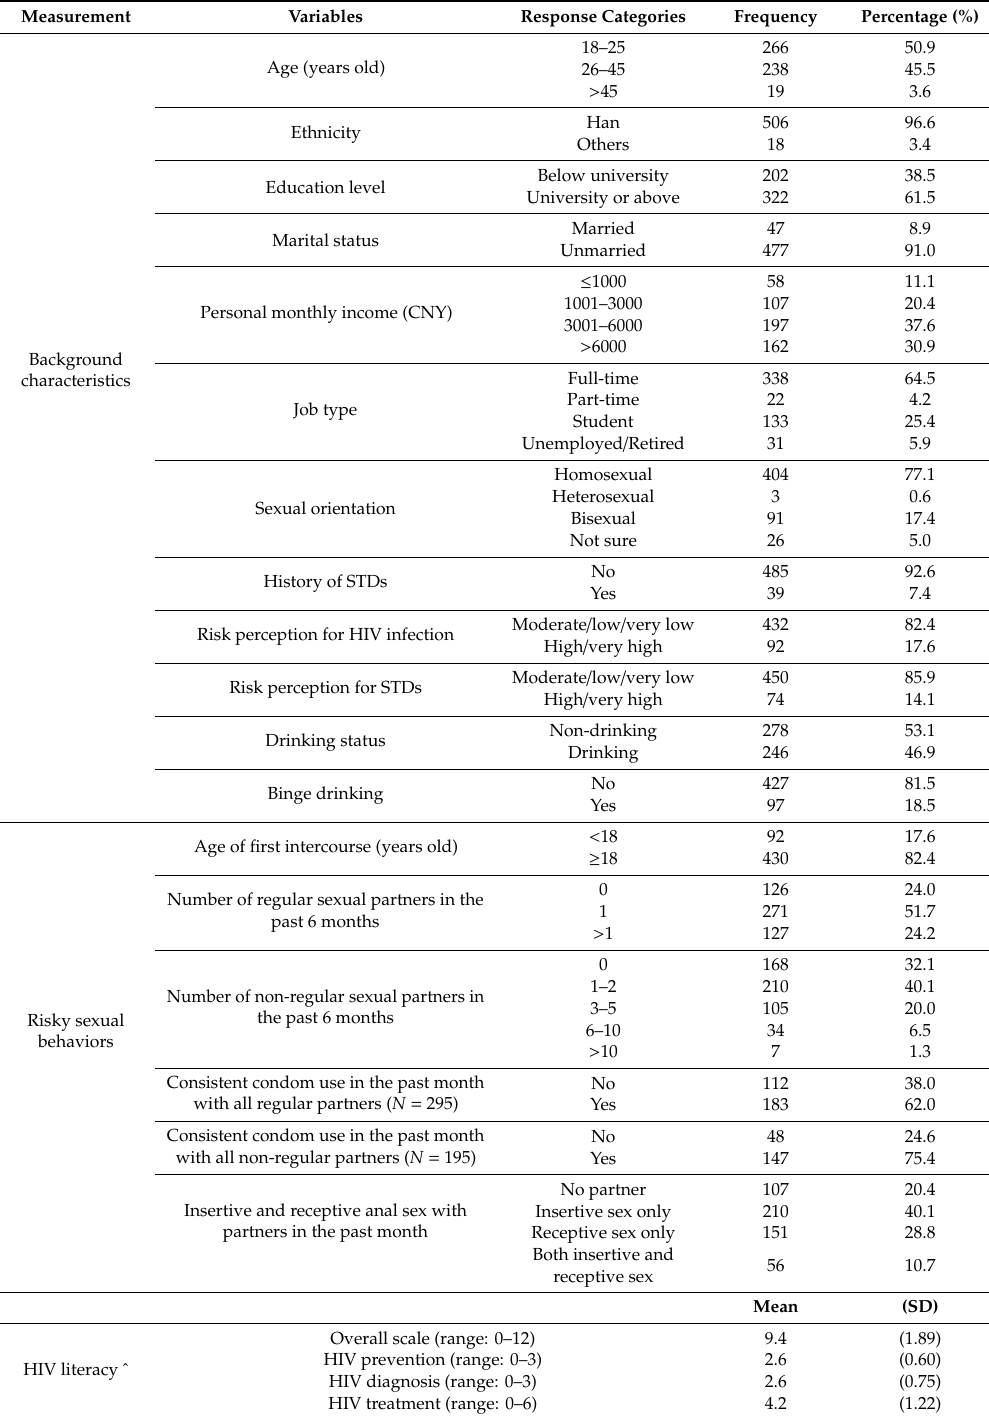
Table 1. Characteristics of participants ( N =